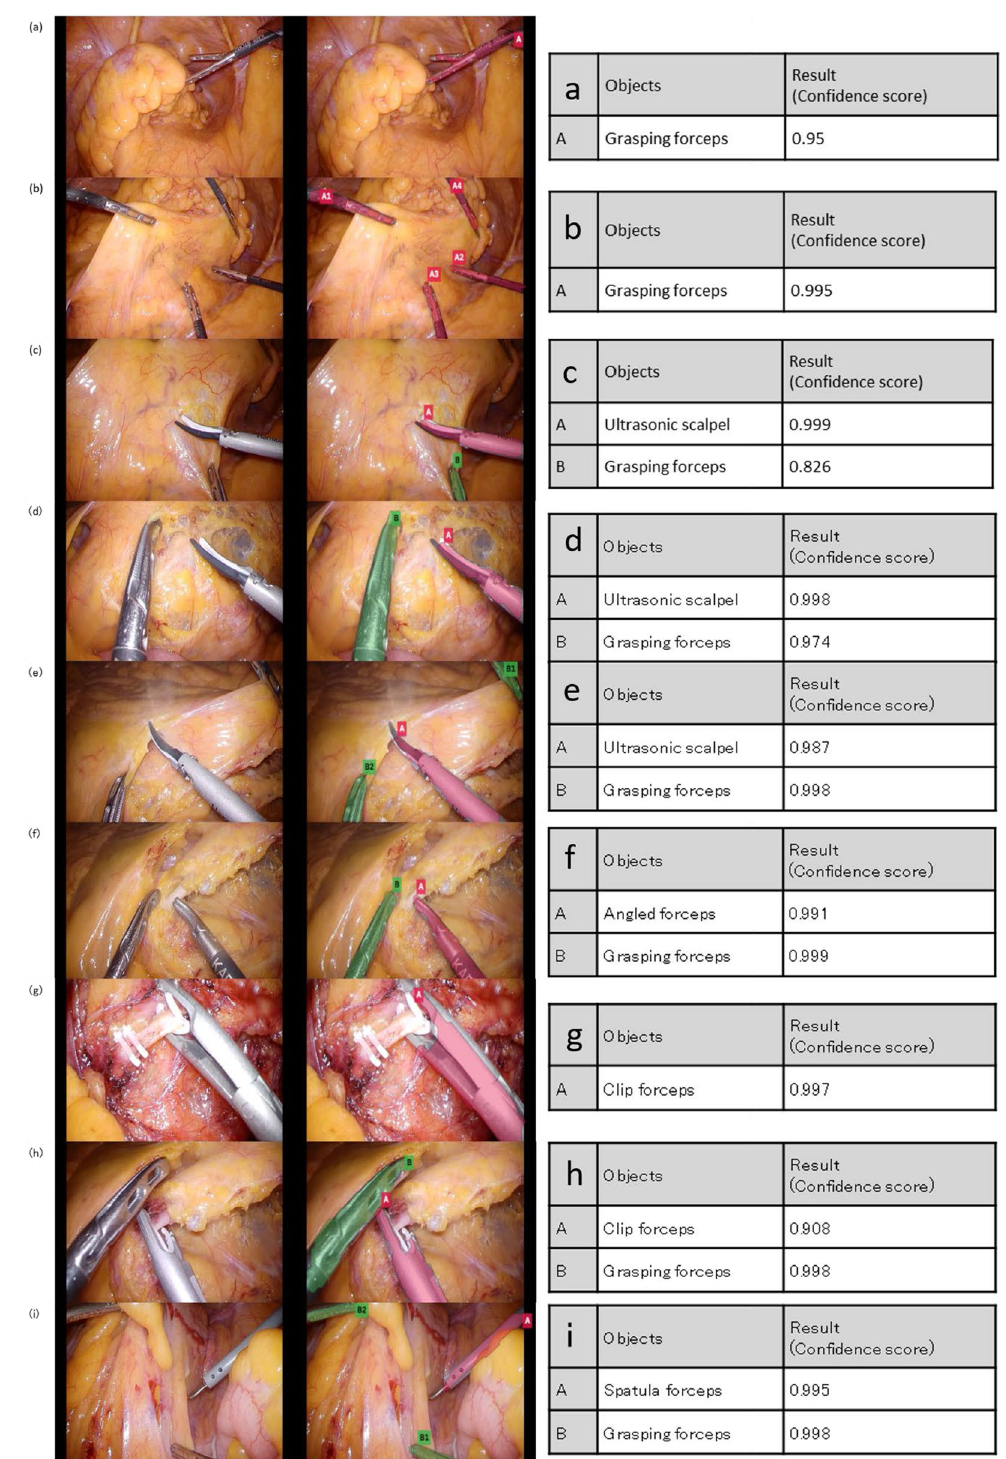
Figure 4. Representative images demonstrating accurate results. The images on the right side are original. The images in the middle are test results. The images on the right side show the confidence scores of each